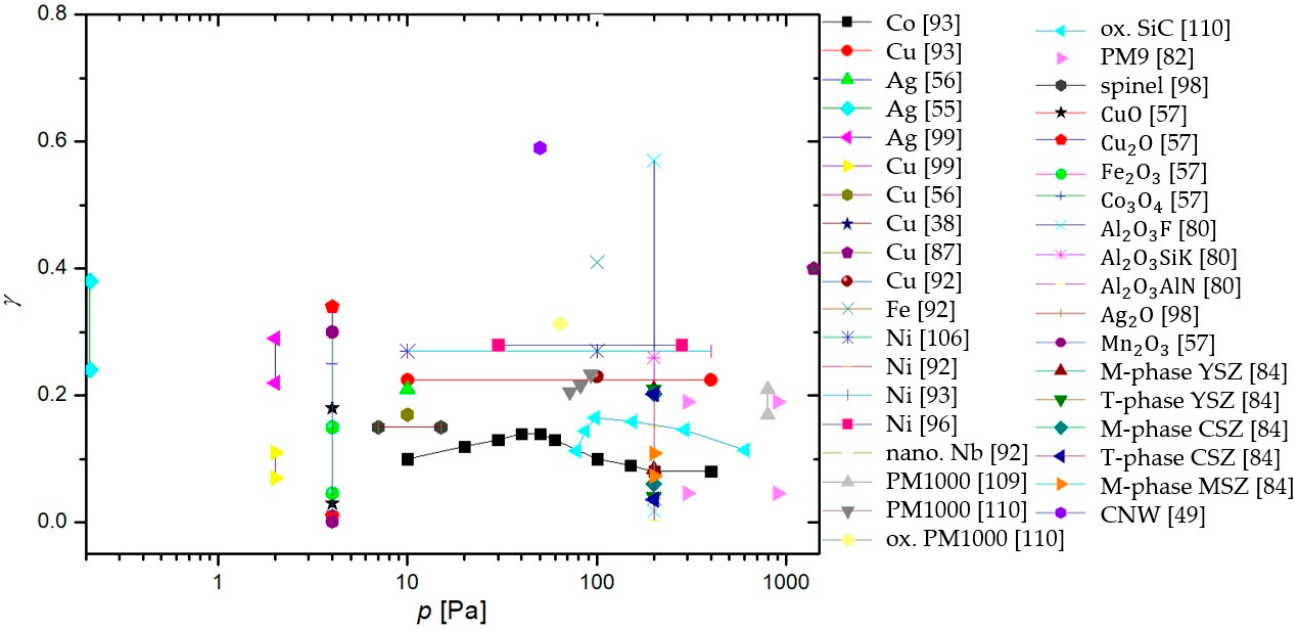
Figure 18. Recombination coefficient ( γ ) of neutral oxygen atoms versus pressure ( 𝑝 ) for various catalytic surfaces.